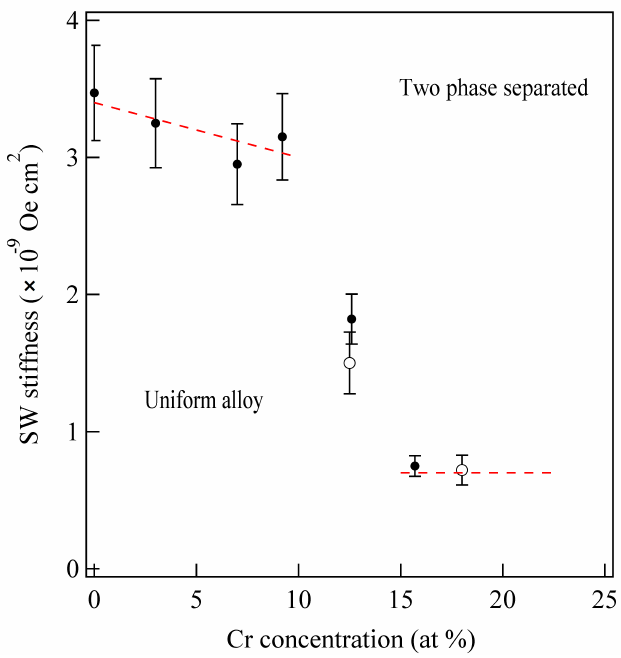
Figure 9. A summary of the SW stiffness constant D of the Co 1 − x Cr x binary system ( x in at % unit) as a function of the Cr content x . We added the D BLS values for x = 12.5 from [65] and x = 18 from [66]. The colored area shows the transition region between the uniform alloy state and the two‑phase separated state. The broken lines give D ( x ) = (3.41 − 0.043 x ) × 10 respectively